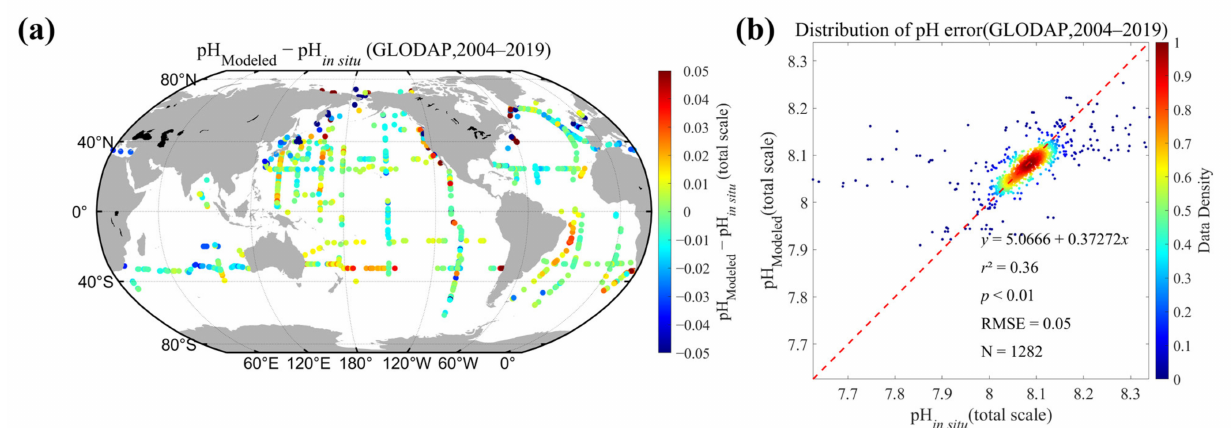
Figure 13. Independence validation based on the GLODAP in situ dataset. ( a ) Spatial distribution of the inversion error at the matchup validation points. ( b ) Point-to-point comparison between the modeled results and the in situ pH along the 1:1 line with R 2 = 0.36, RMSE = 0.050, and n = 1282. The red dotted line is 1:1 line.